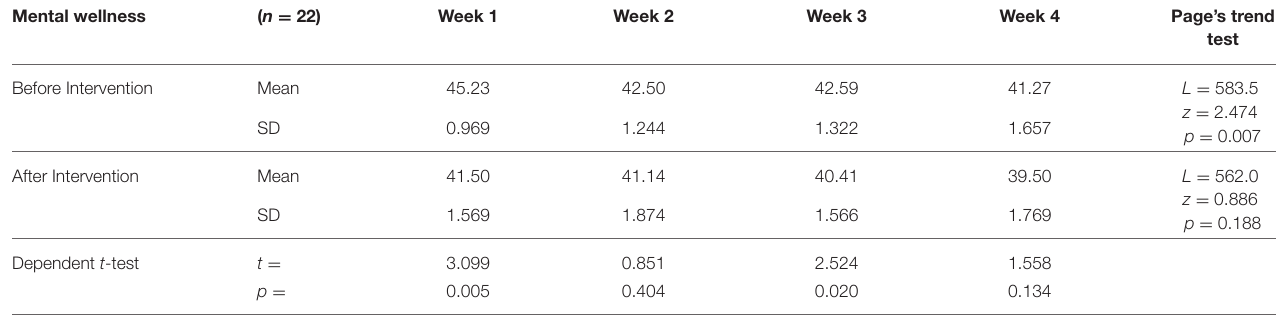
TABLE 5 | Questions about Mental Wellness.